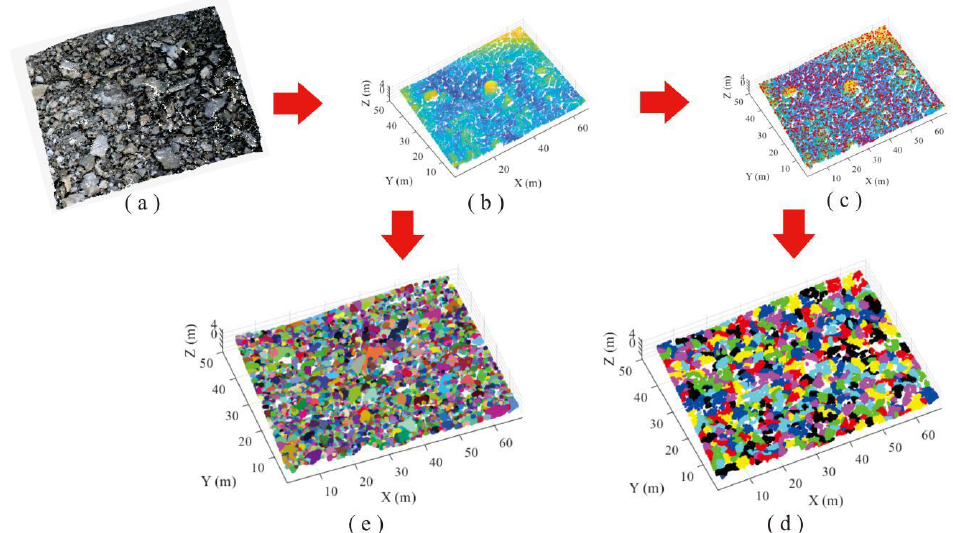
Figure 14. Comparison of recognition performance of upper part of landslide accumulation between